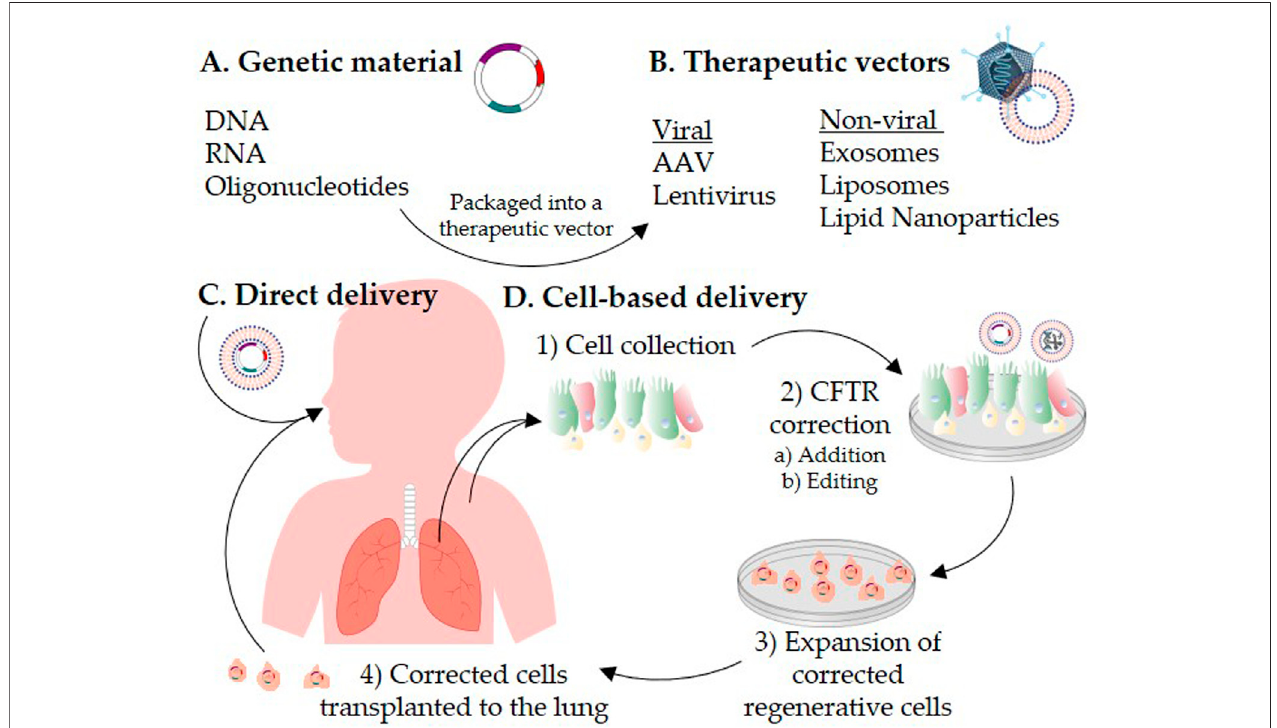
FIGURE1| SchematicrepresentationofCFTRcorrectionstrategiesforthetreatmentofcystic fi brosis.Geneticmaterials (A) arepackagedintoatherapeuticvector (B) .Thetherapeuticvectorisdelivereddirectlytothepatient ’ slungs (C) orintroducedintocells exvivo (D) .Forautologouscell-basedtherapy,1)airwaycellsareisolated fromthepatient ’ srespiratorytractorinducedpluripotentstemcellsaregeneratedfromthepatient ’ sskin fi broblastsorblood.2)CFTRiscorrected invitro inthecollected cells by a) addition or b) editing strategies. 3) The CFTR-corrected regenerative cells are expanded to reach a therapeutic dose, and then 4) transplanted back to repopulate the patient lung